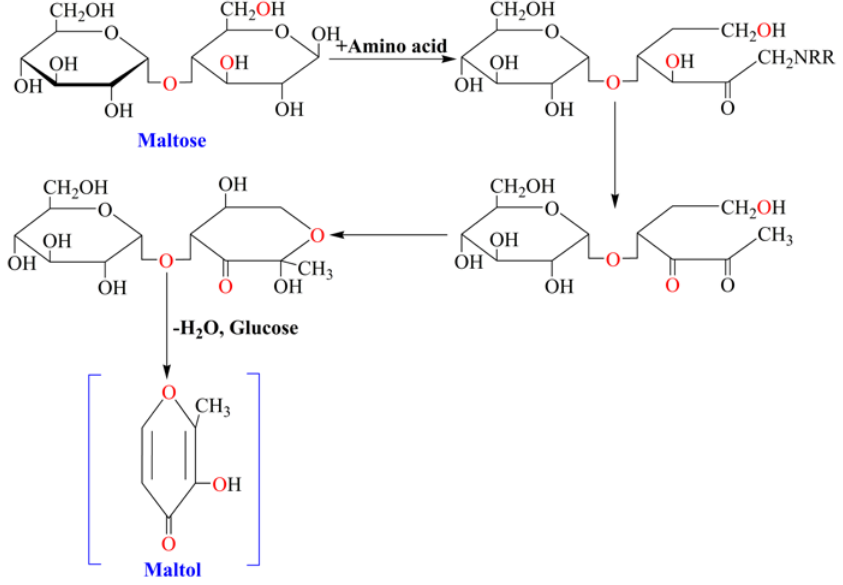
Figure 1. Formation pathway of maltol in maillard reaction between maltose and amino